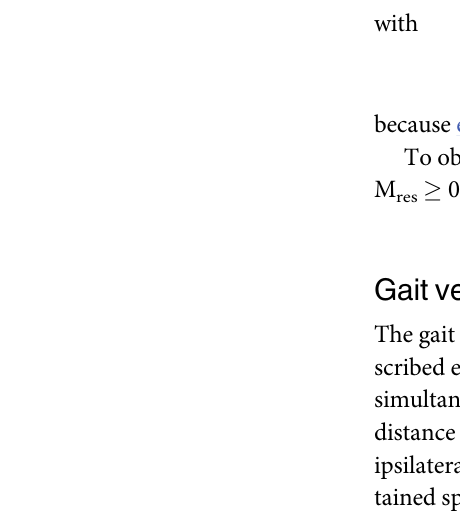
Fig 1. Model for calculating the 3D coefficient of friction μ . In reality, the component F z is measured negatively, and the direction of F res is thus towards the ball surface